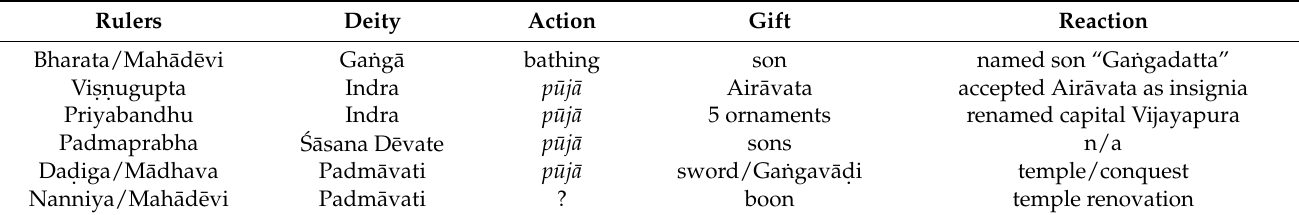
Table 1. Interactions between Ga˙nga rulers and the divine in inscription EC VII